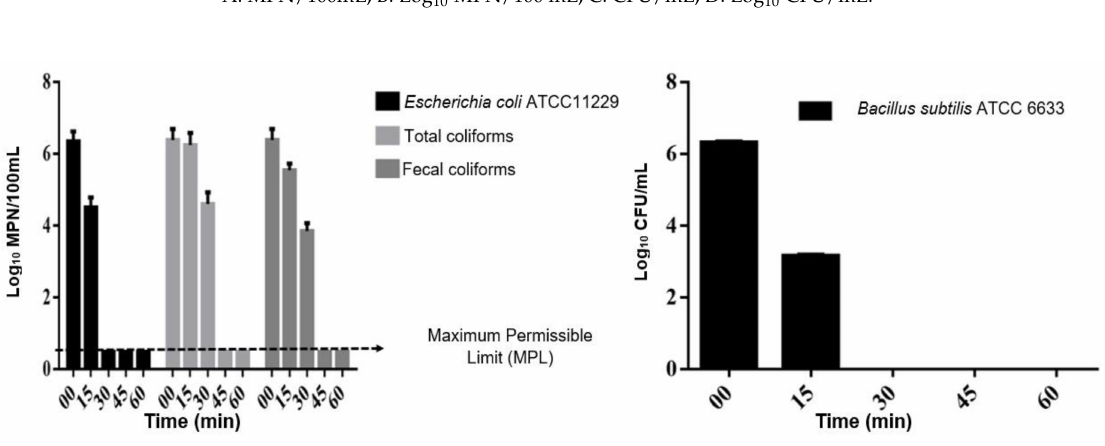
Figure 2. Treatment with ultrasound at a frequency: 20 kHz, amplitude: 35% and sonication time: 15, 30, 45, 60 min. on ( a ) total and fecal coliforms, and E. coli and ( b ) Bacillus